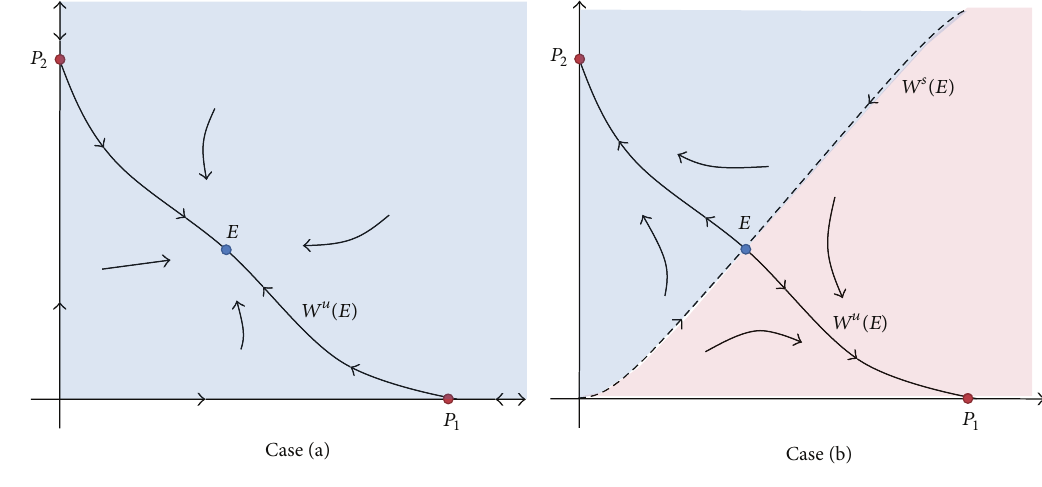
Figure 1: Global dynamics of System